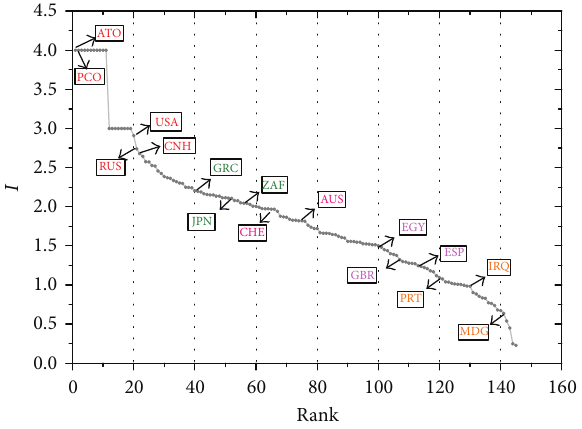
Figure 7: Node importance versus corresponding